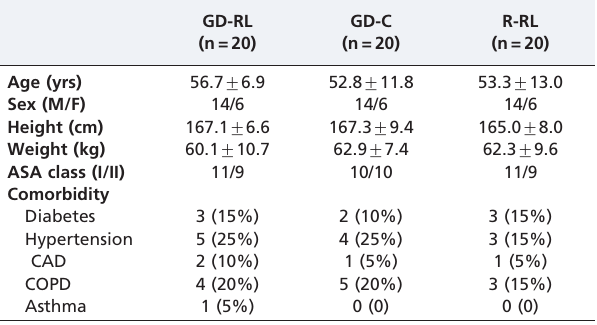
Table 1 - Patient demographic data and clinical